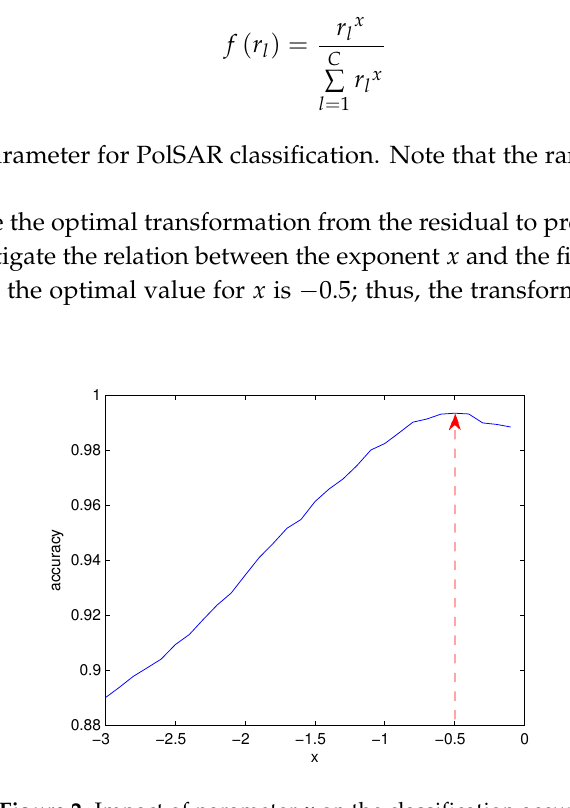
Figure 2. Impact of parameter x on the classification